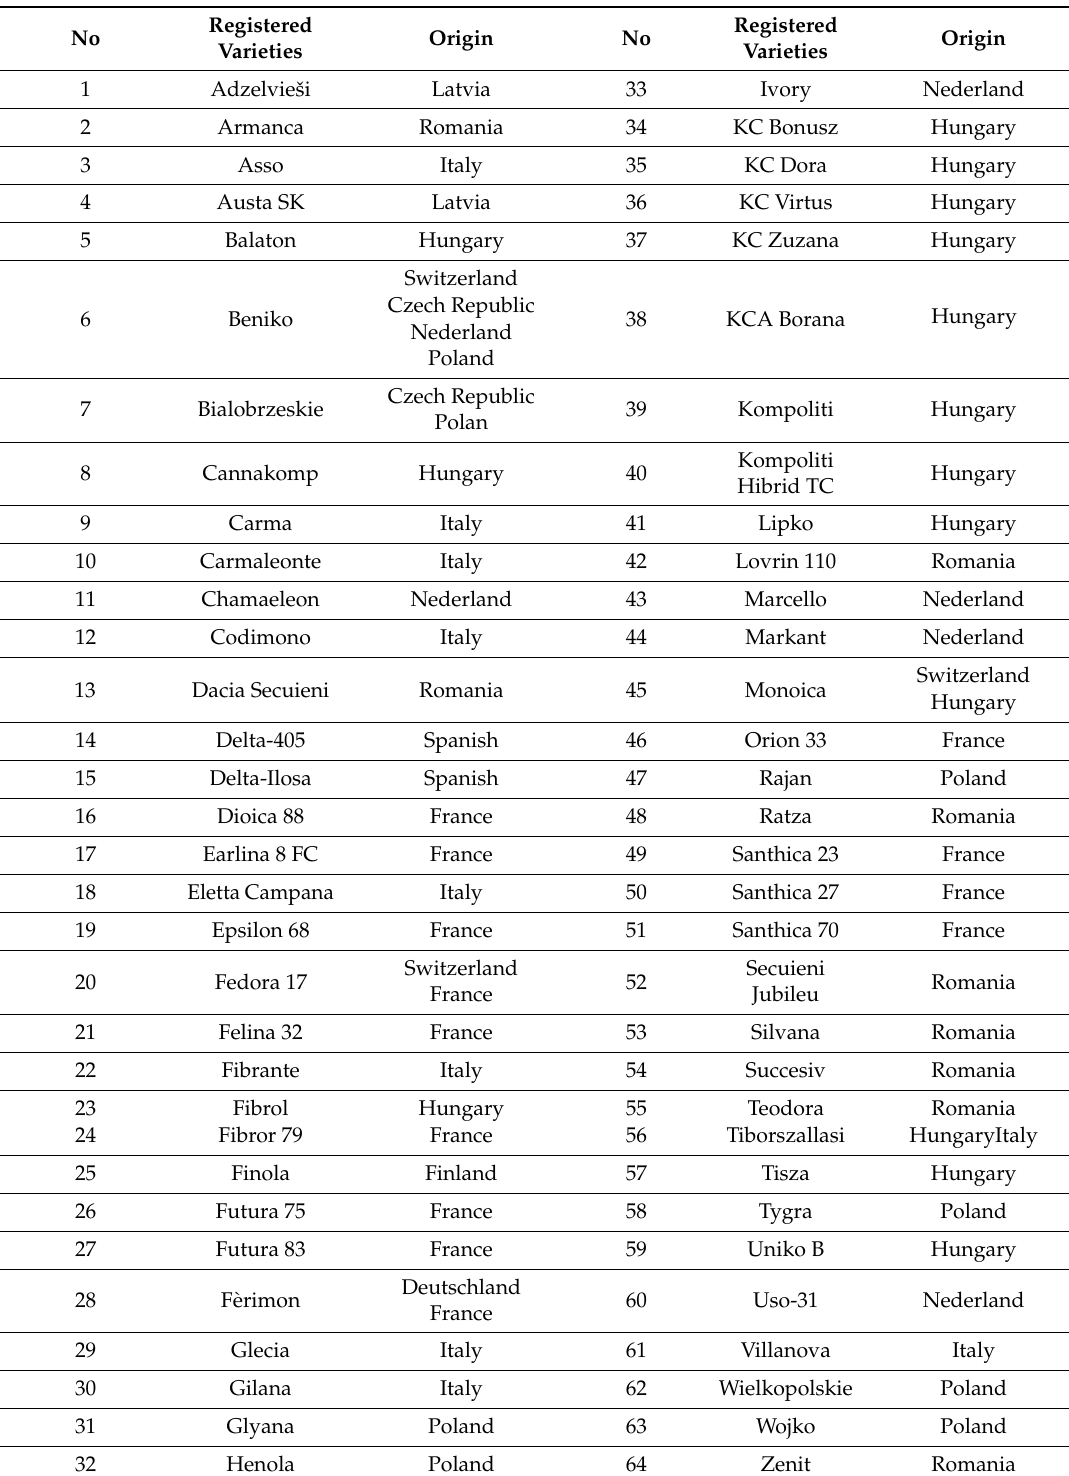
Table 1. Industrial hemp cultivars registered and listed in the European Union Plant Variety Database and their origin. All these varieties are certified to contain less than 0.2% of THC of dry weight of leaves and flowering parts of the plant, according to the EU regulation 1307 /